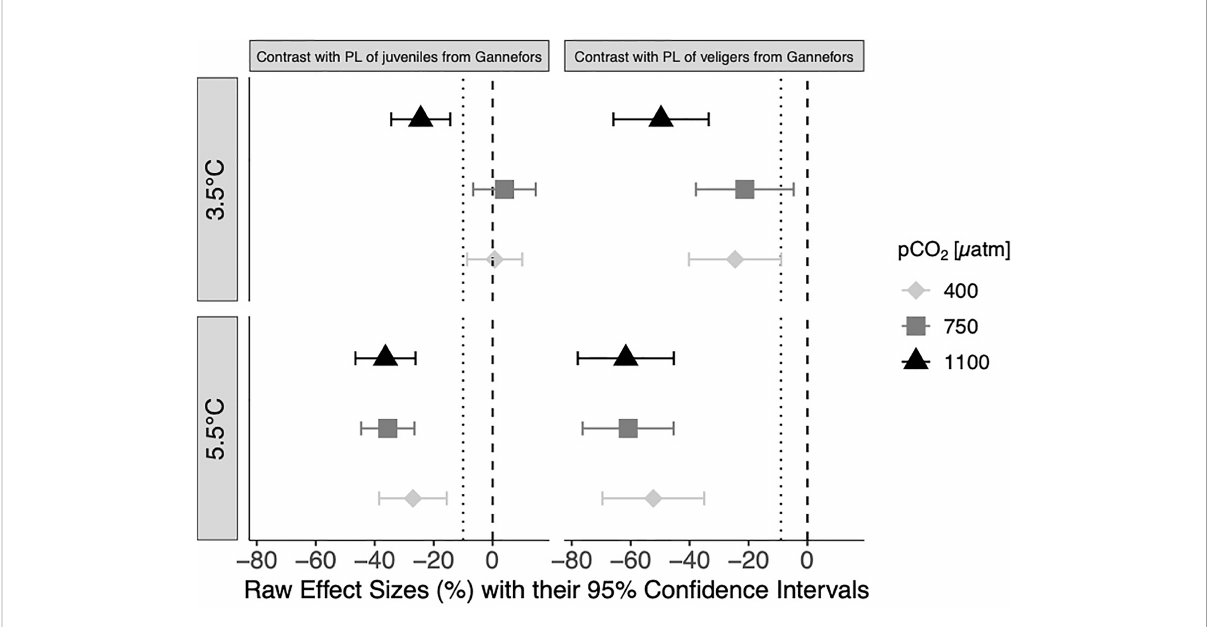
FIGURE 8 Mean differences D (raw effect sizes) and their 95% con fi dence intervals of percent contribution of phospholipids (PL) between Limacina helicina in the experimental treatments and of juvenile and respectively veligers of L. helicina collected in Kongsfjord in 2001 by Gannefors and co- workers. The dotted line in each subplot indicates − 1 standard deviation ( ‘ 1-SD-line ’ ) of the mean phospholipid portion of the in situ juveniles (SD 10) and veligers (SD 9) (Gannefors et al., 2005). Deviation larger than − 1 SD is considered an unsustainable ecological